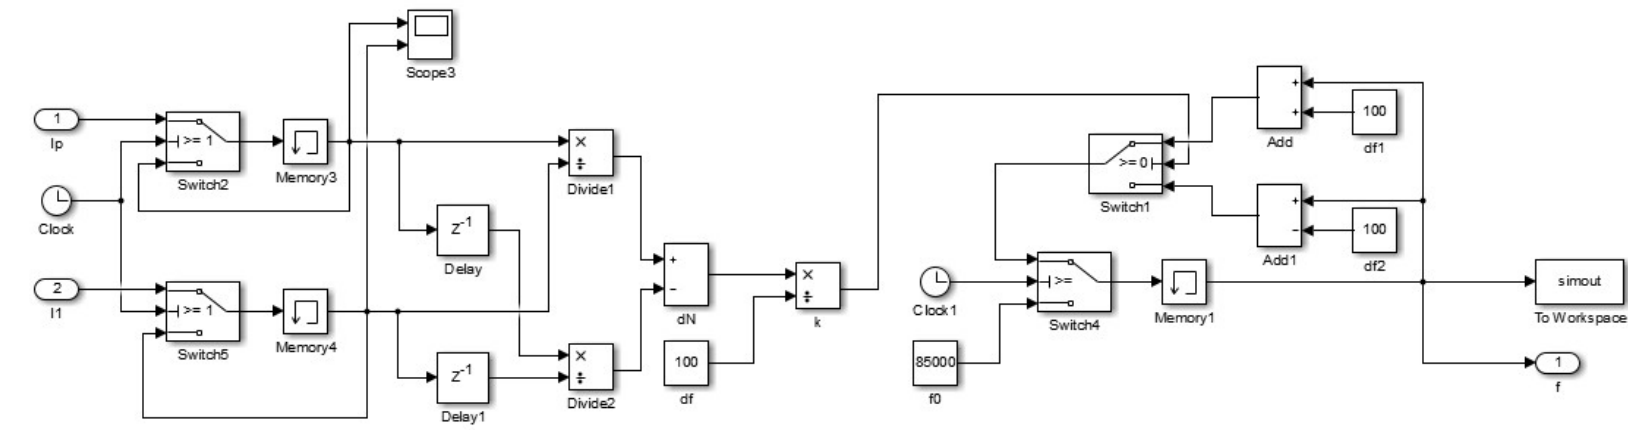
Figure 13. Controller arrangement plan of load adjustment method.